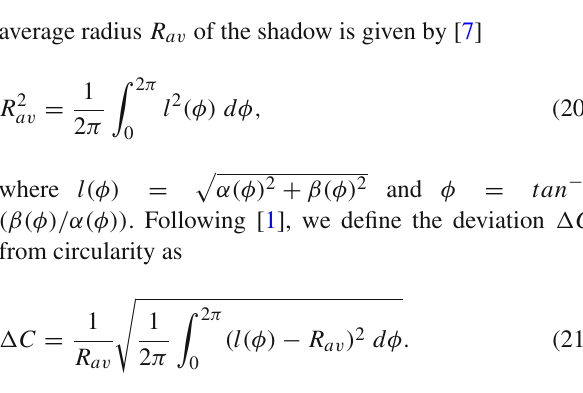
average radius R a v of the shadow is given by [7]